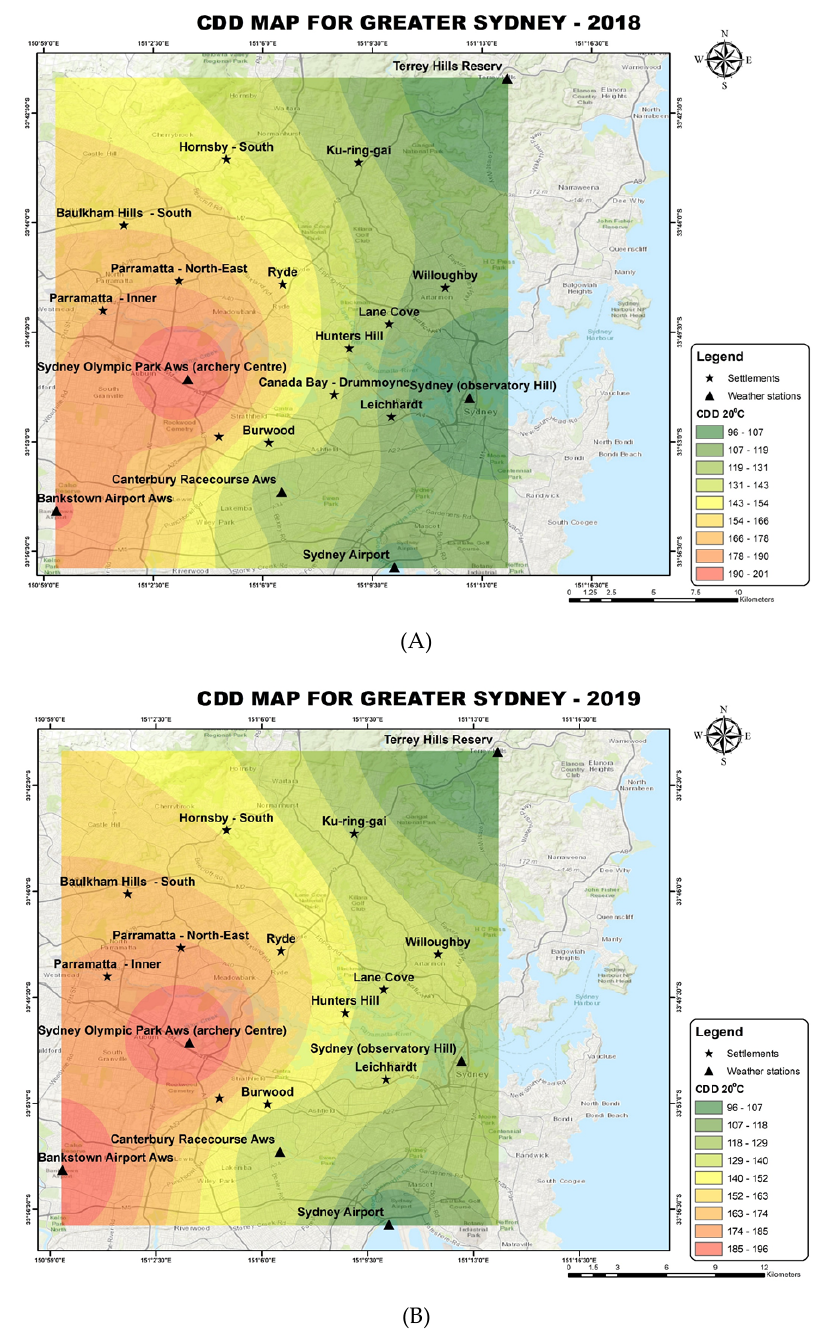
Figure 2. Patterns of UHI intensity in Greater Sydney, based on cooling degree days (CDD) ( A ) 2018 ( B ) 2019.